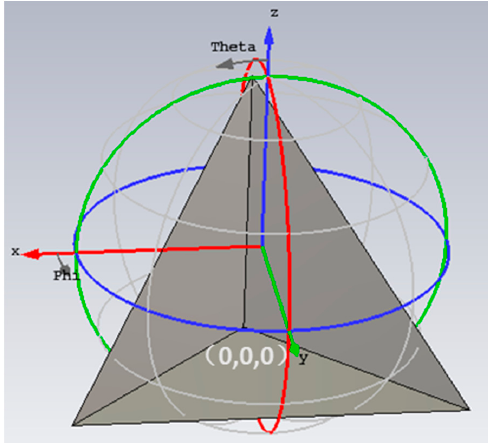
Figure 6. 3-D CAD model of the trihedral.